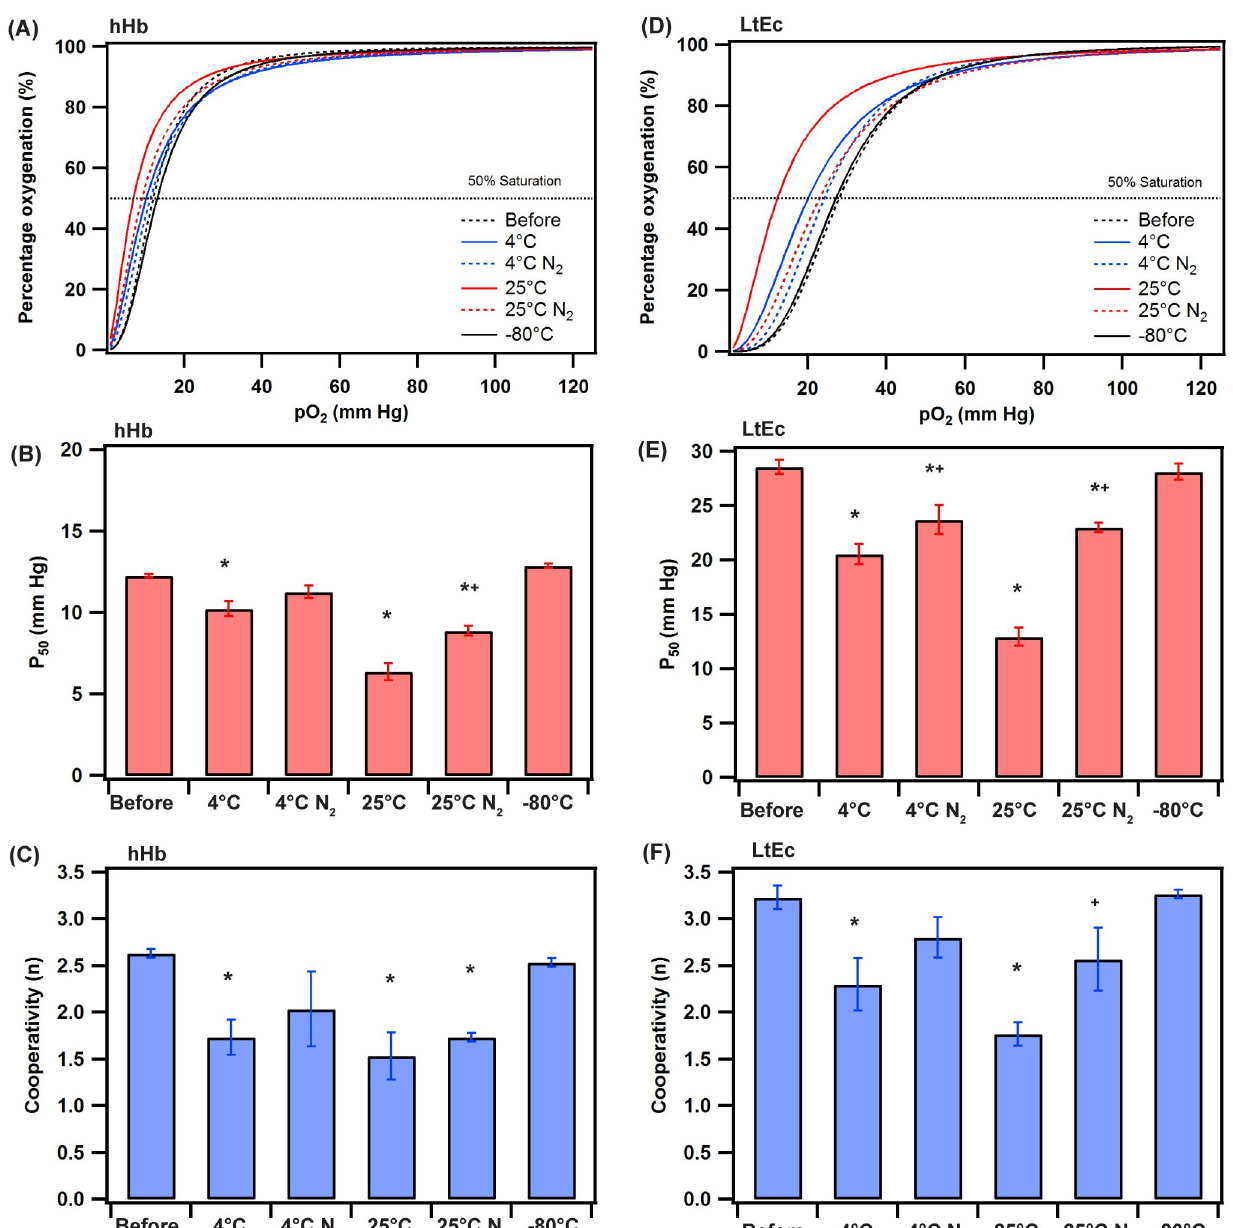
Fig 3. (A, D) Oxygen equilibrium curves of hHb and LtEc pre and post lyophilization stored for 6 months under different conditions. (B, E) Partial oxygen pressure at 50% O 2 saturation of hHb or LtEc (P 50 ). (C, F) Cooperativity coefficient (n). � p < 0.05 compared to before lyophilization. + p < 0.05 compared to the same temperature condition in the absence of N 2